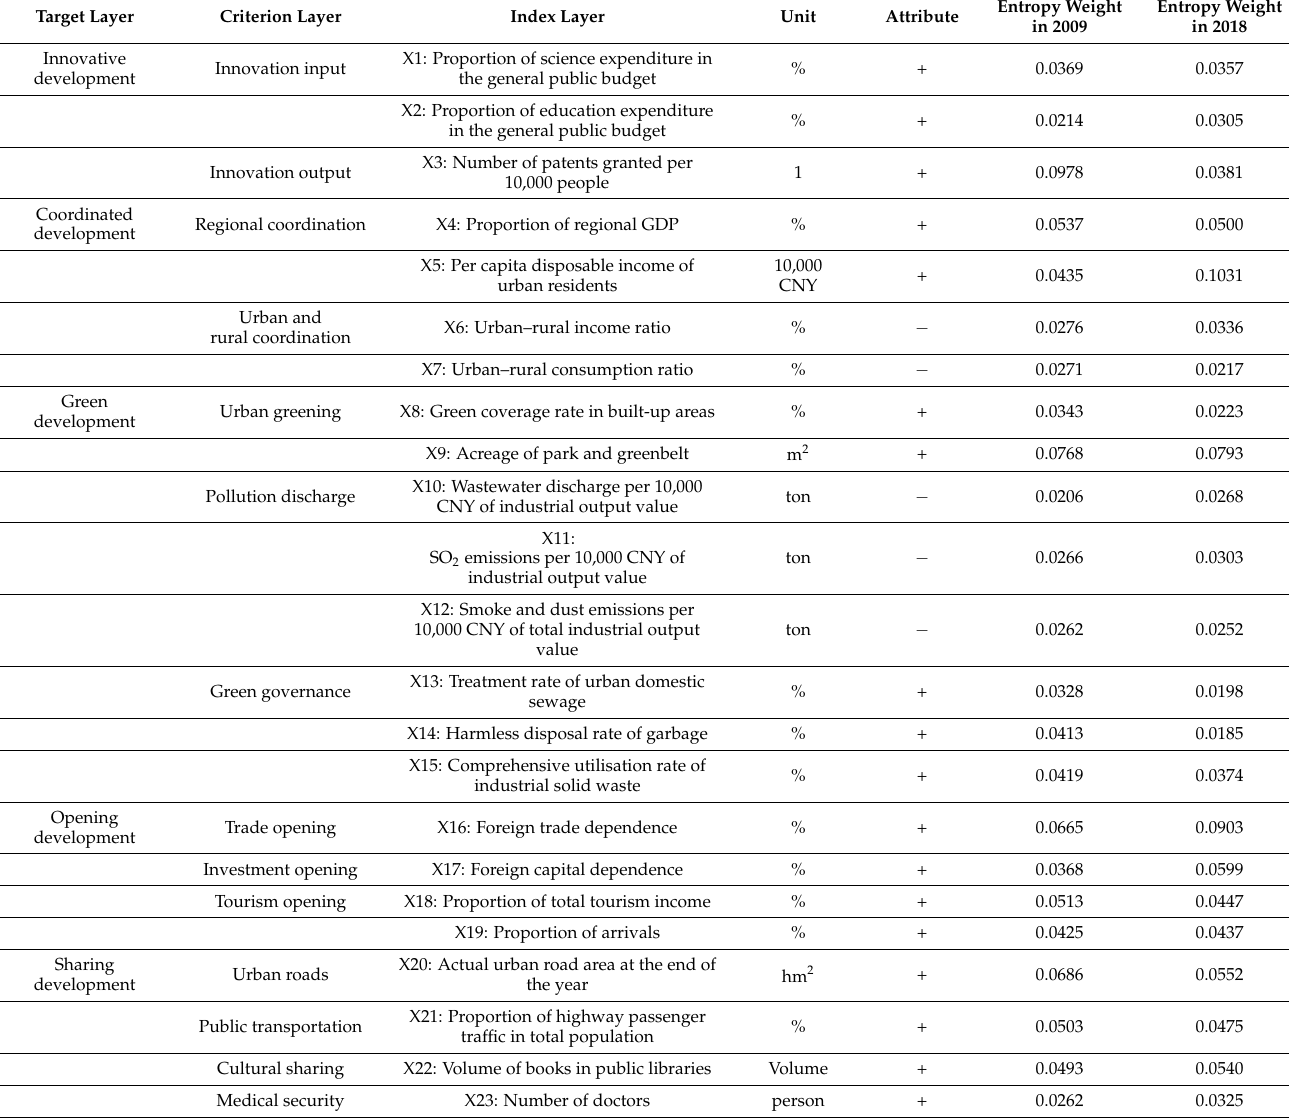
Table 1. Evaluation index system for HQD of urban